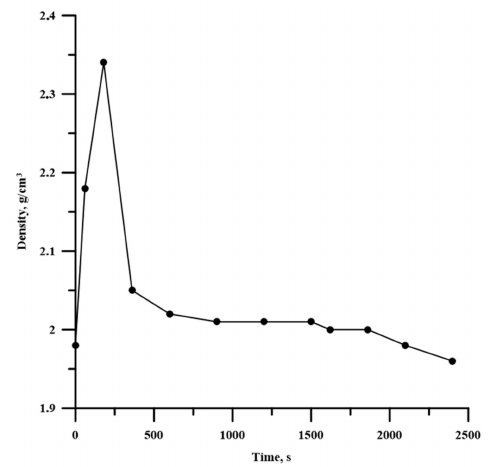
Figure 6. Dependence between the time of planetary milling and the density of the Al-Ti-B powder